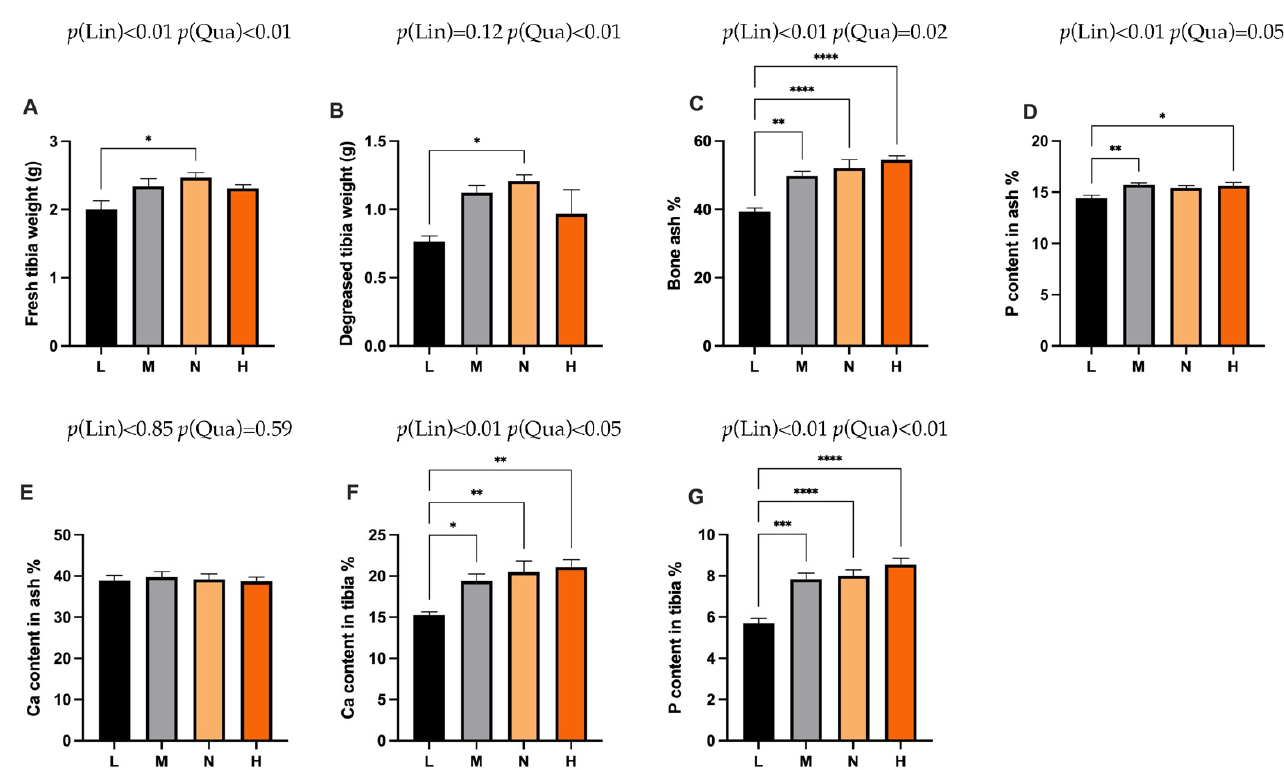
Figure 4. Effects of phosphorus restriction in brooding stage on tibia characters of layers at 6 weeks of age. ( A ) Fresh tibia weight ( B ) Decreased tibia weight ( C ) Bone ash ( D ) P content in ash ( E ) Ca content in ash ( F ) Ca content in tibia ( G ) P content in tibia. Data are shown as mean ± SEM. * p < 0.05, ** p < 0.01, *** p < 0.001, **** p < 0.0001, p (Lin) = p -value (linear effect), p ( Qua) = p -value (quadratic effect). L = group fed 0.13% nPP; M = group contained 0.29% nPP; N = group contained 0.45% nPP; H = group contained 0.59% nPP. n = 6 per group.